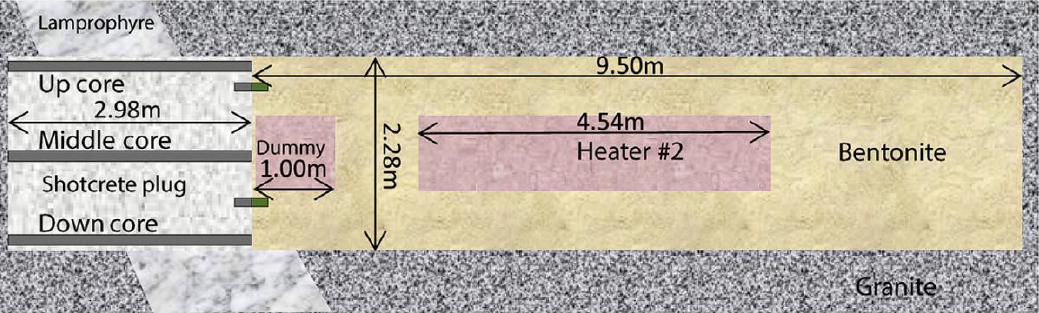
Figure 22. Longitudinal section of the FEBEX setup and location of drilled concrete cores [6].